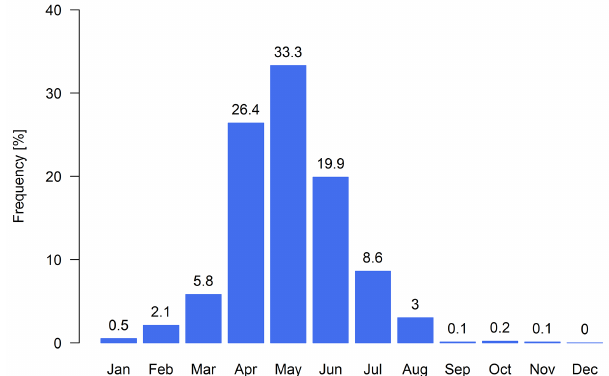
Figure 7. Monthly mudflow frequencies (bars) for the years 1870– 2014. Values over the bars indicate the percentage of mudflow oc- currences in a given